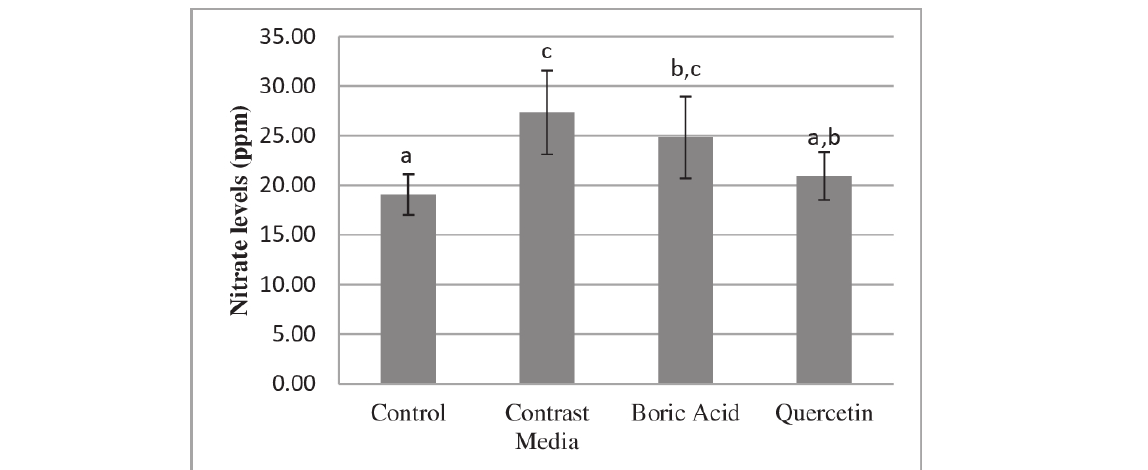
FIGURE 4 - Changes in serum nitrate levels among the groups in our study. Statistically insignificant differences are indicated by identical letters, and statistically significant differences are indicated by different letters. P <0.05 was considered statistically